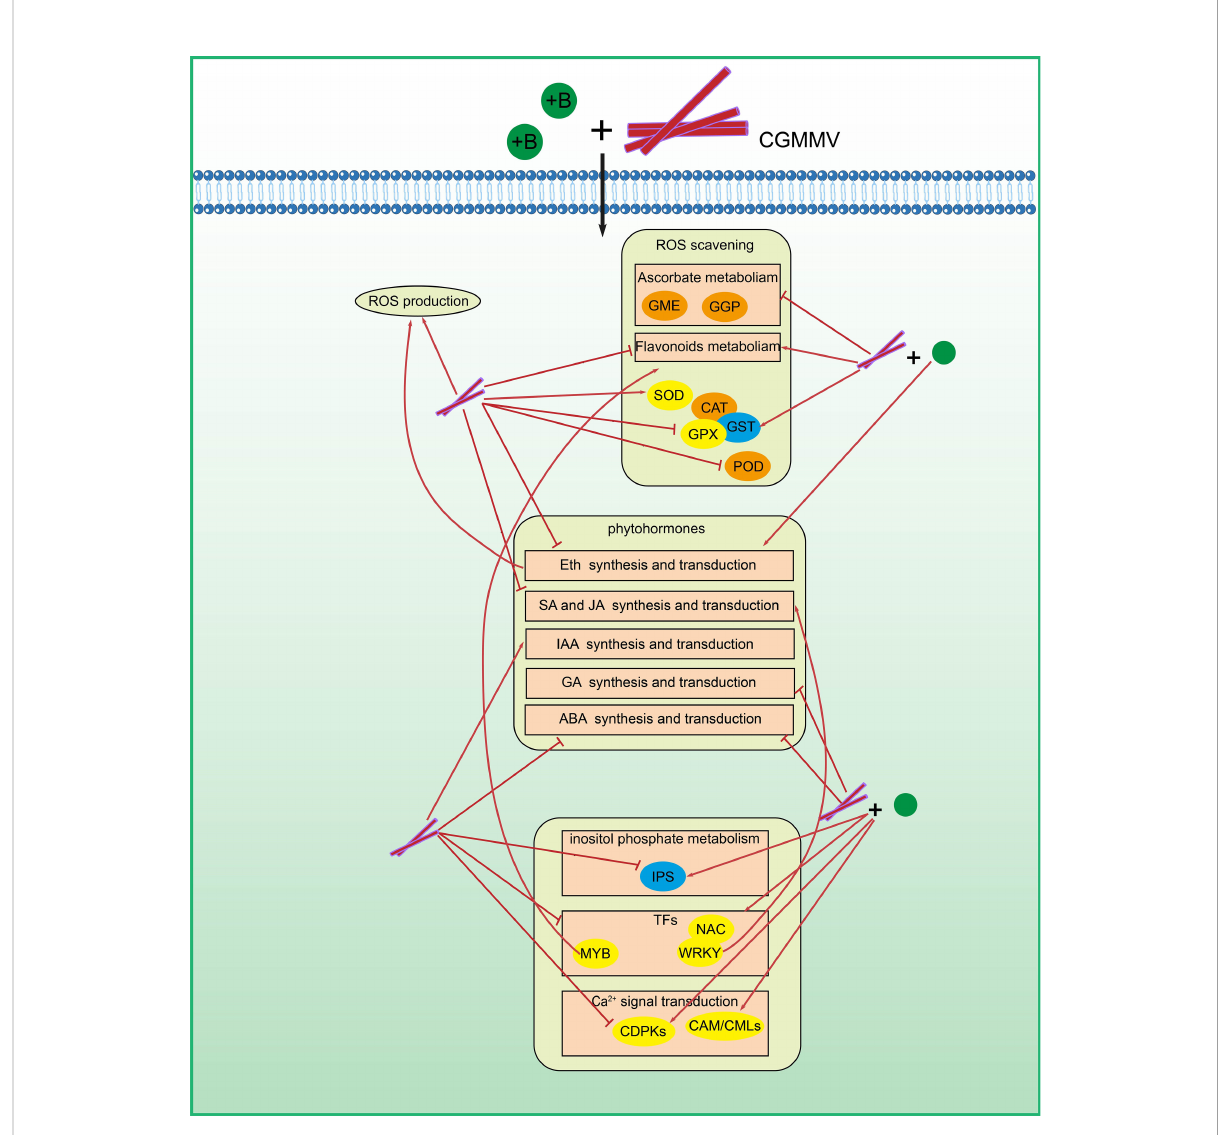
FIGURE 9 A proposed model for the possible roles of ROS-related genes in resistance to CGMMV infection regulated by boron. Genes in orange boxes were required for CGMMV infection in N. benthamiana . Genes in blue boxes played anti-CGMMV roles in N. benthamiana . Genes in yellow boxes responded to CGMMV infection and / or boron